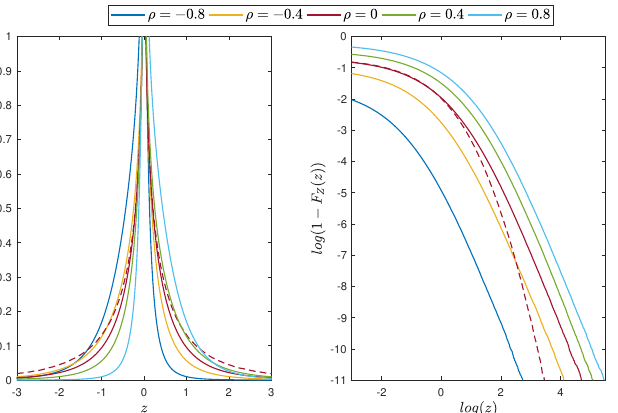
Figure 6. Distribution of the product of the marginal random variables from the two-dimensional Student’s t distribution with n = 5 and different values of the ρ parameter. ( Left panel ): the PDF of the random variable Z . ( Right panel ): the distribution tail for the random variable Z (in log-log scale). The dotted line corresponds to the case when X and Y random variables are independent and n X = n Y = 5. The colors of the solid and dotted lines correspond to the same ρ